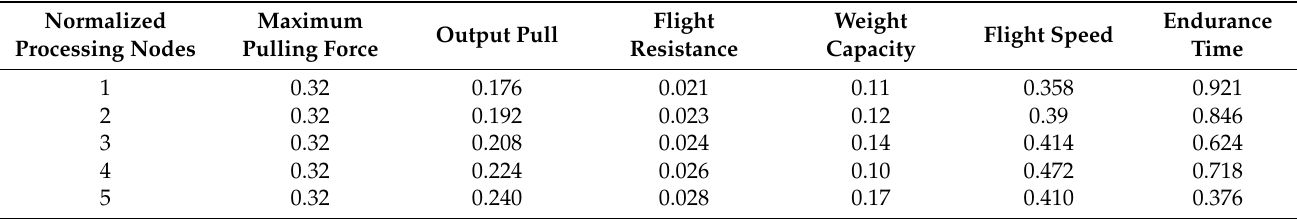
Table 2. Six nodes and experimental results after the normalization process.